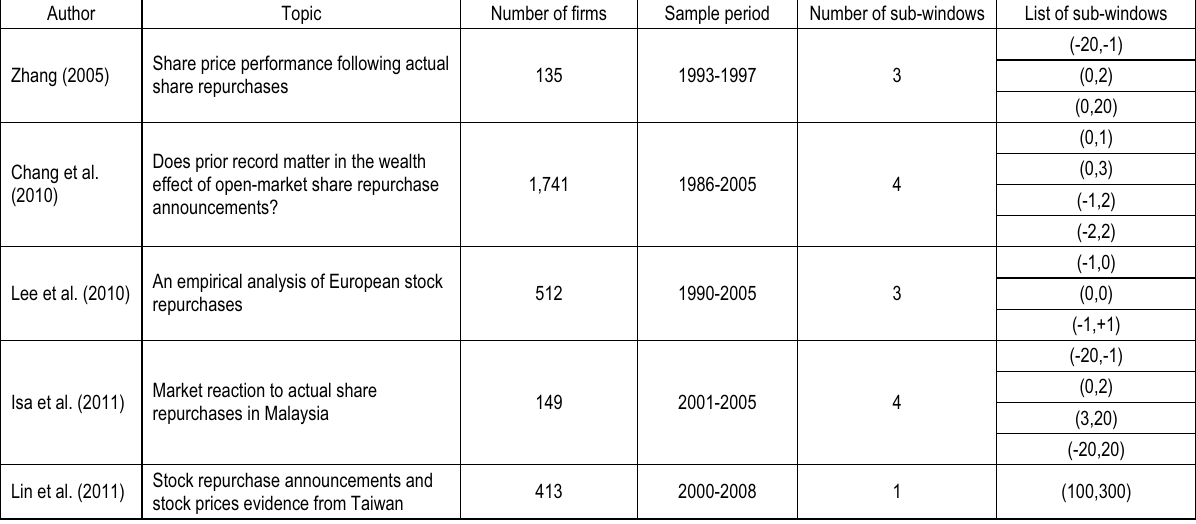
Table 1. Share repurchase related studies and some characteristics